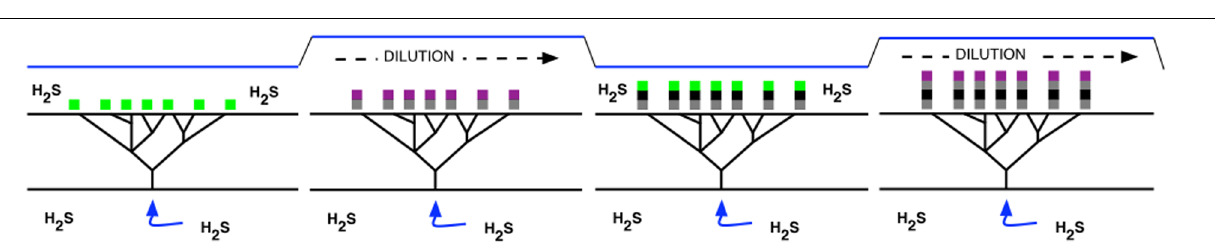
FIGURE 6 | A model for formation and growth of stromatolites. Sequential concentration and dilution of hydrothermally derived H 2 S results in alternation of Types I and II photosynthesis, and in alternation of photoautotrophy and photoheterotrophy. Sequential deposition of layers of cellular material from each mode of metabolism produces a laminar substrate that raises the growing microbial mat incrementally nearer to the surface of the water and source of